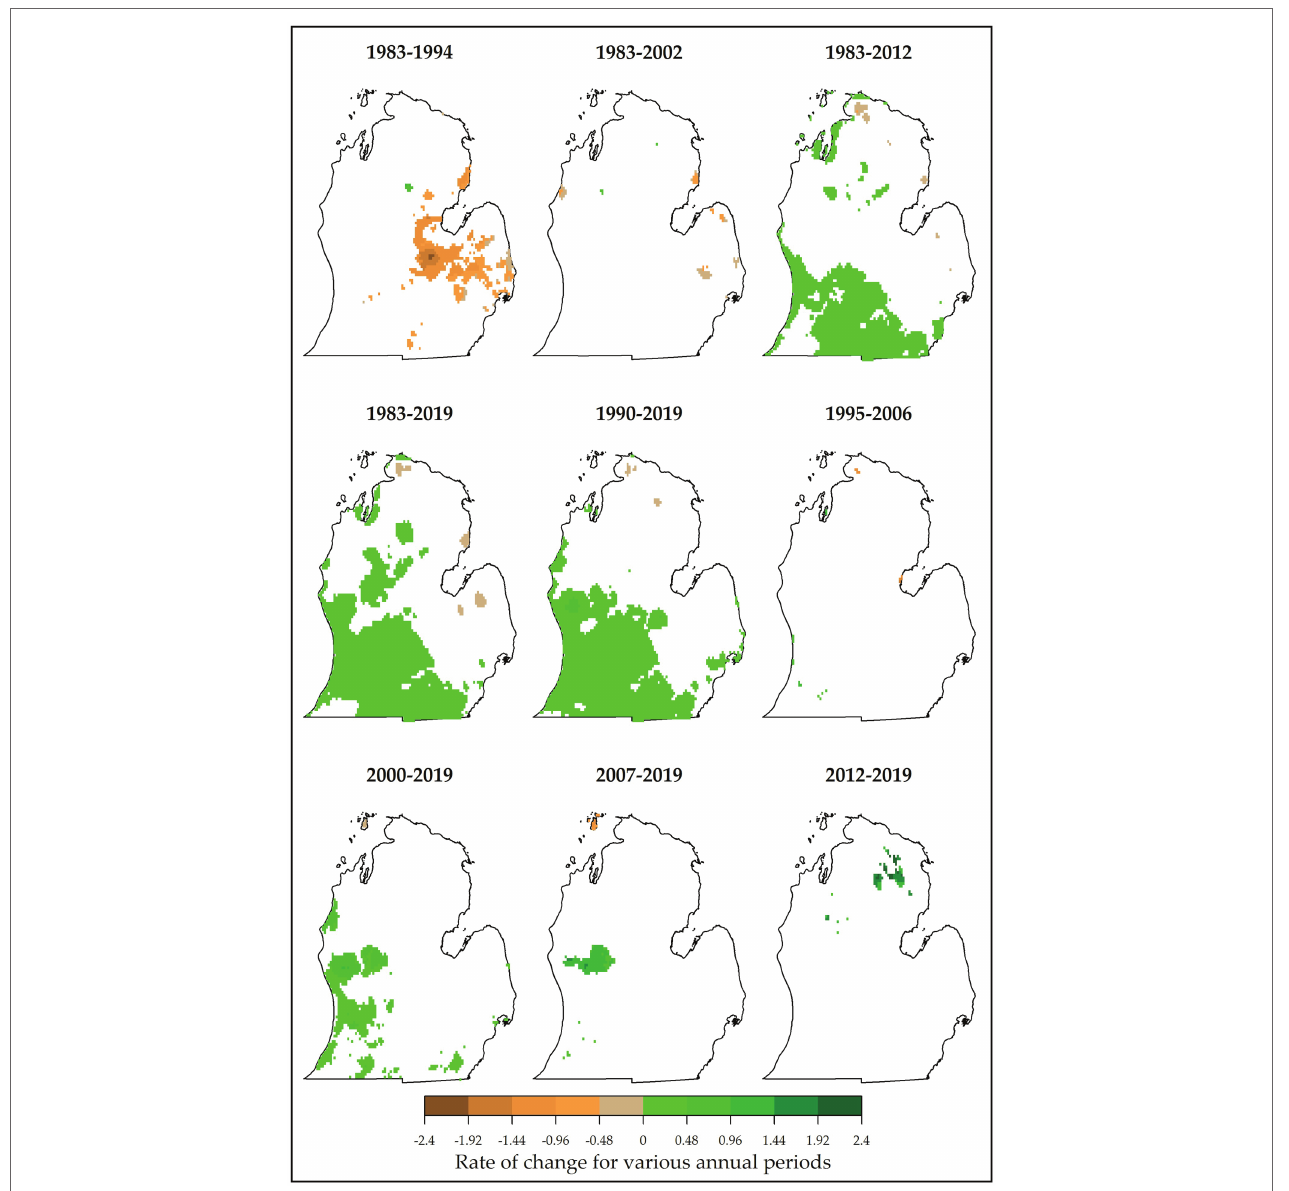
FIGURE 4 | Slope values (Kendall τ ), indicative of magnitude of change in annual numbers of frost-free days (FFDs; days per year) for different study periods (at α = 0.10 level). Highest proportions of changed area were found in 1990–2019, 1983–2019, and 1983–2012. However, greatest changes in FFDs were observed in 1983–1994 ( − change) and 2012–2019 (+ change). White pixels indicate no significant change. For reference, typical FFDs in Lower Peninsula MI range from 145 to 215 days per year ( Table 1